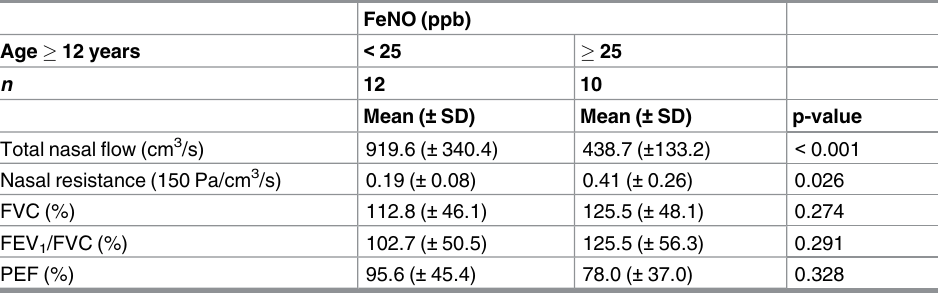
FeNO: fractional exhaled nitric oxide, FVC: forced vital capacity, FEV 1 : forced expiratory volume in 1 s, PEF: peak expiratory flow. p values < 0.05 were considered to indicate statistical significance.